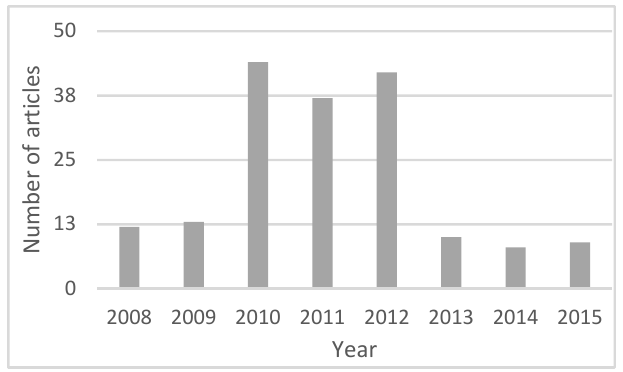
Figure 1. Number of